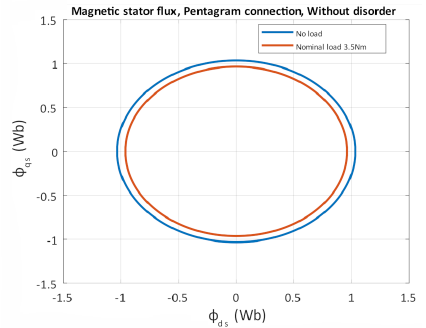
Figure 19. Magnetic stator flux, pentagon connection, without disorder.